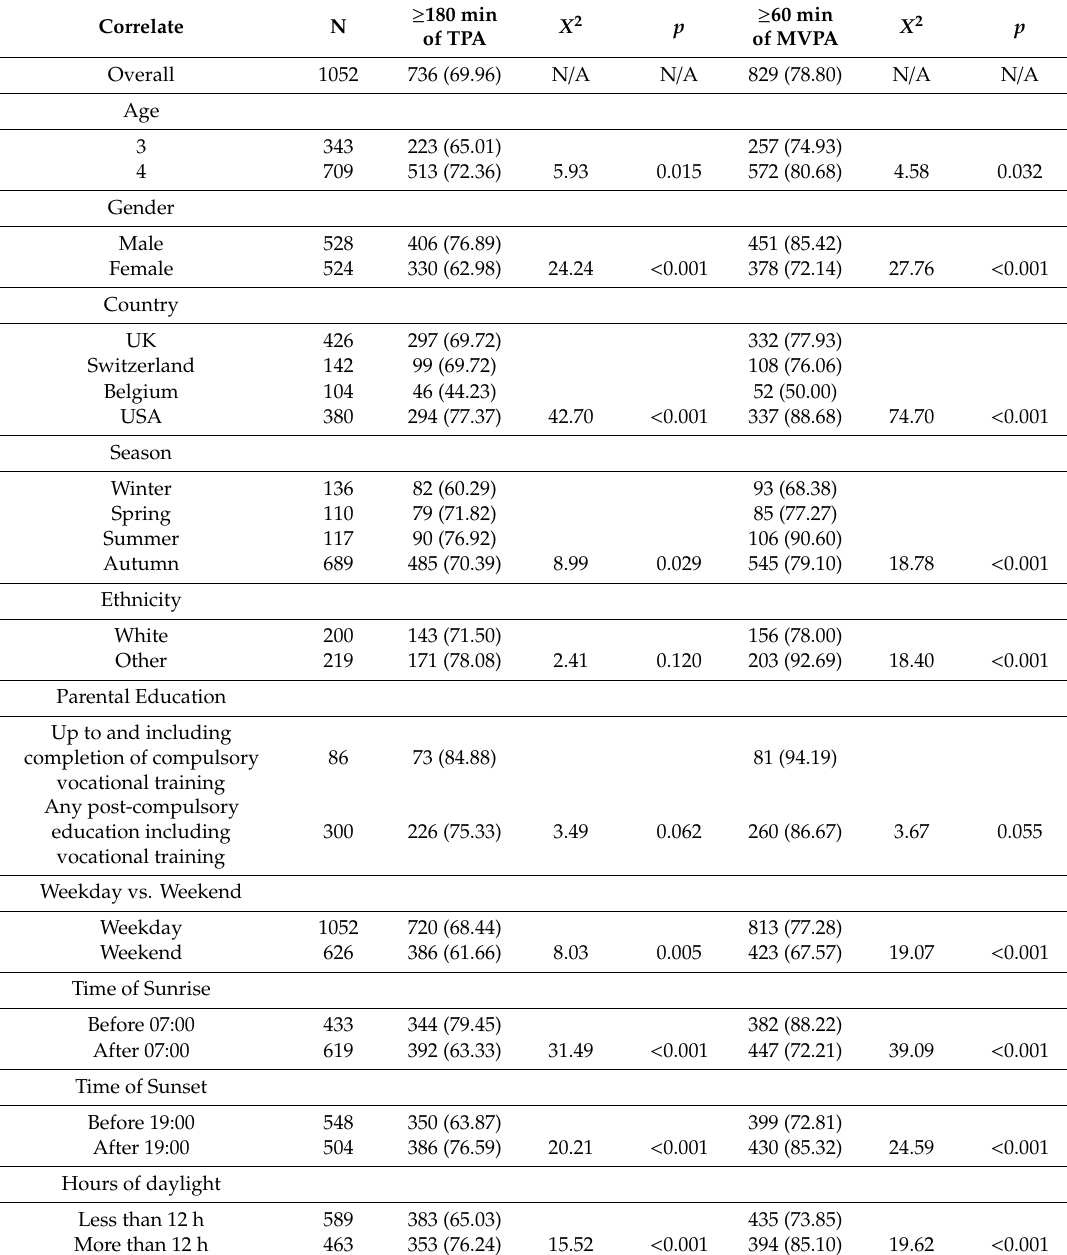
Table 2. Frequency and percentage of children meeting internationally recognized guidelines of ≥ 180 min of total physical activity per day and ≥ 60 min of moderate-to-vigorous physical activity per day by the di ff erent